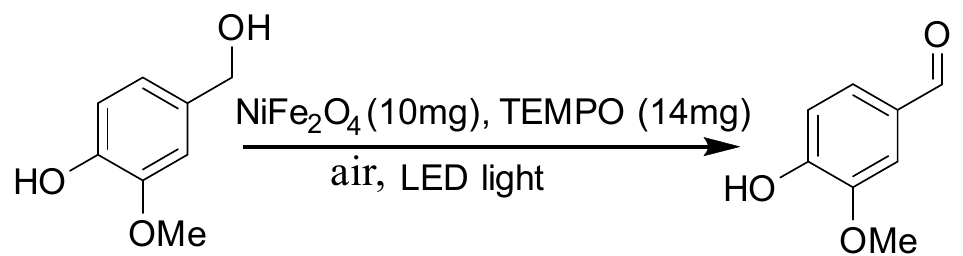
air, air, Scheme 1. Photocatalytic oxidation of vanillyl alcohol using NiFe 2 O 4 -NPs. Scheme 1. Photocatalytic oxidation of vanillyl alcohol using NiFe 2 O 4 -NPs. Scheme 1. Photocatalytic oxidation of vanillyl alcohol using NiFe 2 O 4 -NPs. The optimization was performed with respect to the catalyst loading (0, 5, 10, 15, and